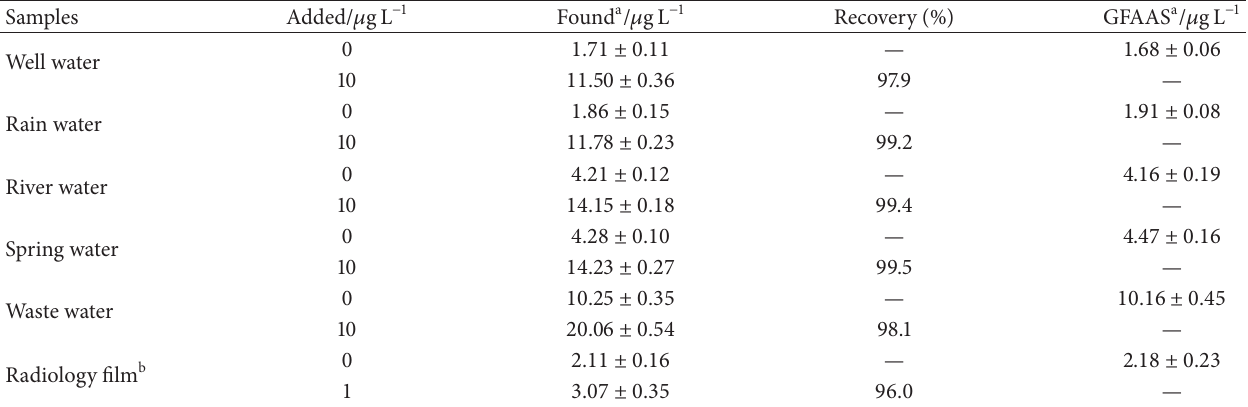
Table 2: Determination of silver in water samples and radiology film.